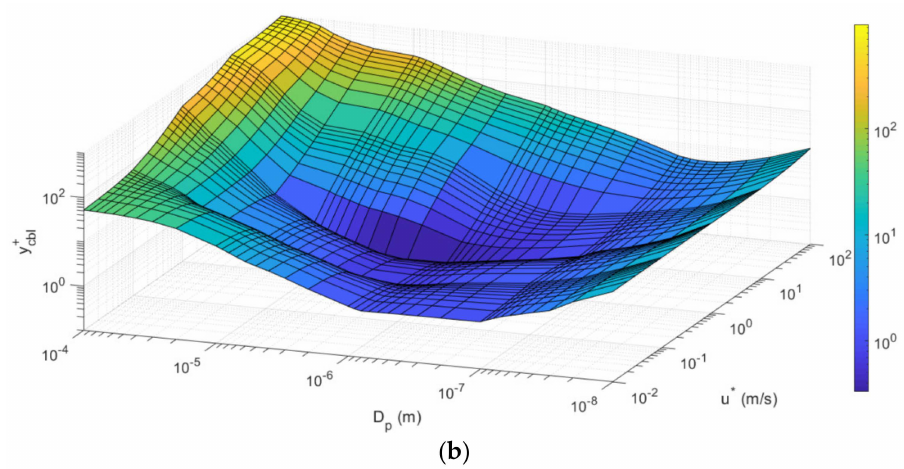
Figure 5. Dependence of y + cbl on particle size ( τ + p or D p ) and friction velocity ( u* ) when gravita- tional settling is added to Fickian diffusion: ( a ) profile of y + cbl as a function of the dimensionless relaxation time τ + p for three friction velocities. ( b ) y + cbl as a function of D p (10 nm–100 µ m) and u* (0.01–100 m/s).